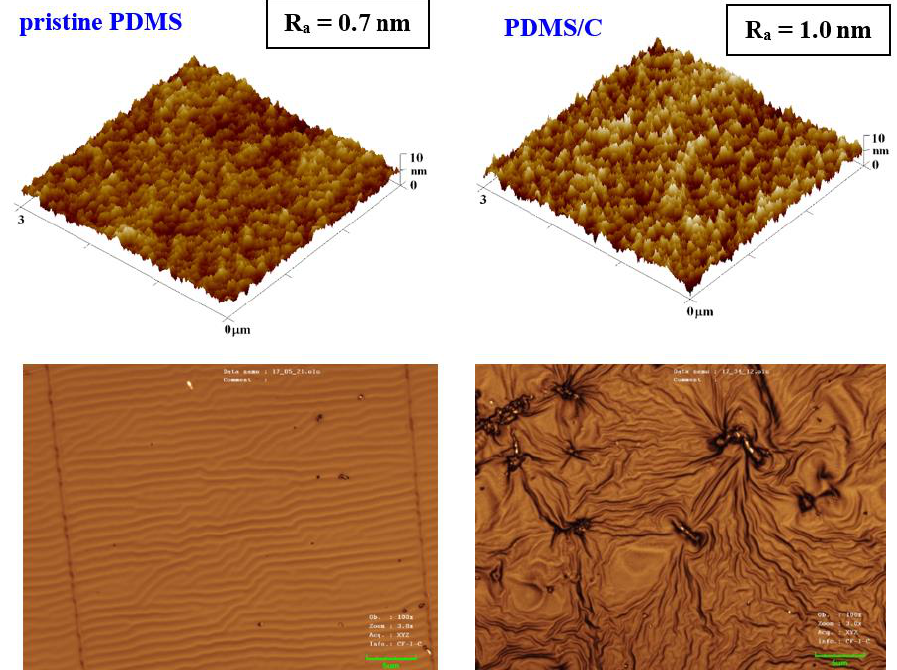
Figure 1. Surface morphology of a pristine PDMS foil and PDMS with 2 wt.% of carbon nanotubes (PDMS/C) in the upper part of the image; bottom images represent laser confocal microscopy scans of the same samples subsequently treated by plasma at 8 W for 240 s (a selected area of 43 × 32 μm 2 ). The procedure of heat treatment was also applied to samples that were doped